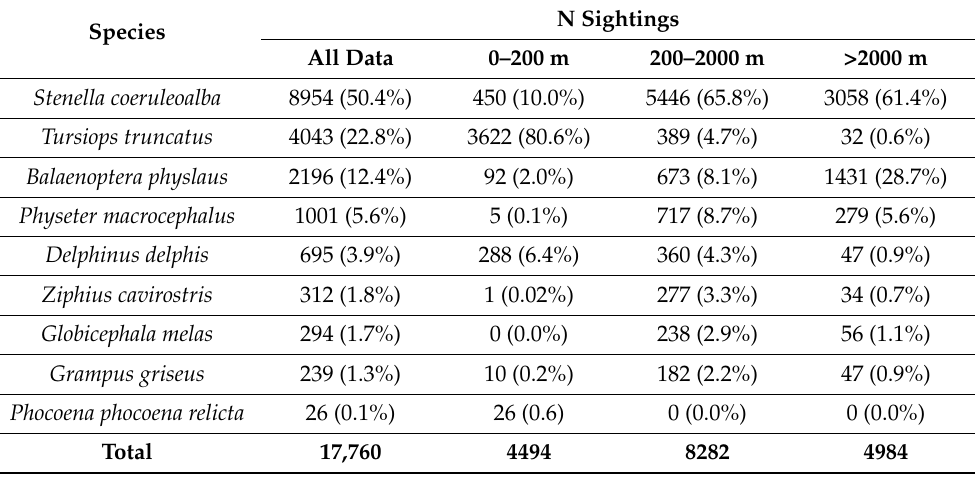
Table 2. Sighting distribution of the nine regularly observed species in the bathymetric domains (0–200 m, 200–2000 m, >2000 m).